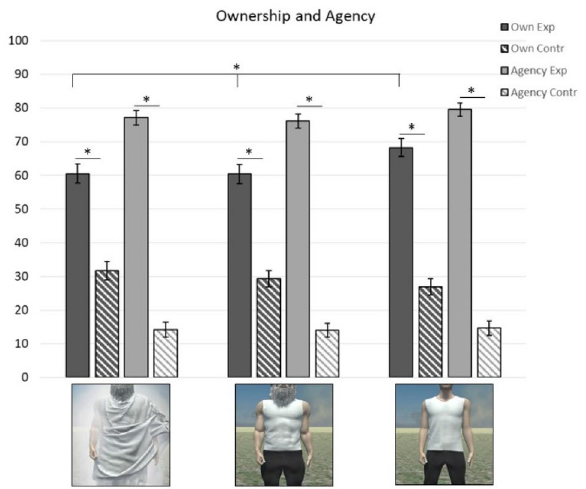
Figure 4. Embodiment illusion scores for each avatar: Dark bars and striped dark bars represent the mean scores of Ownership-experimental items and controls, respectively. Grey and stripped grey bars represent the mean scores of Agency-experimental items and controls,